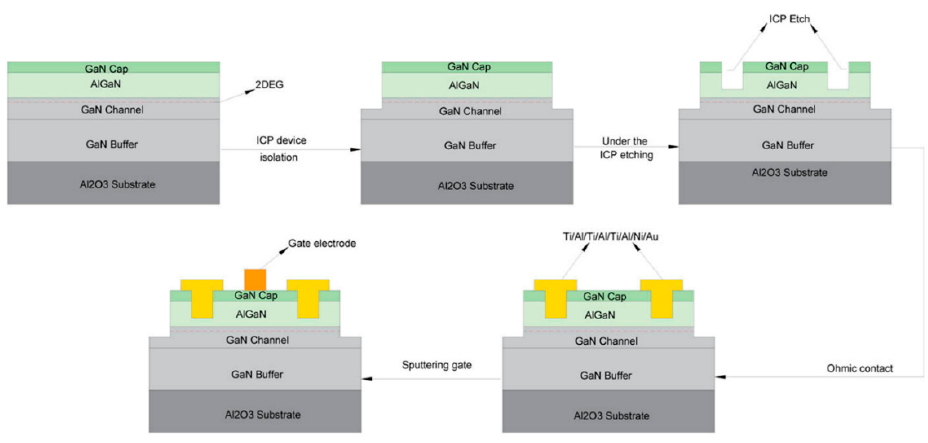
Figure 21. Process flowchart for device etching with an ohmic groove in Ti/Al/Ti/Al/Ti/Al/Ti/Al/Ni/Au. The procedure implemented the inductively